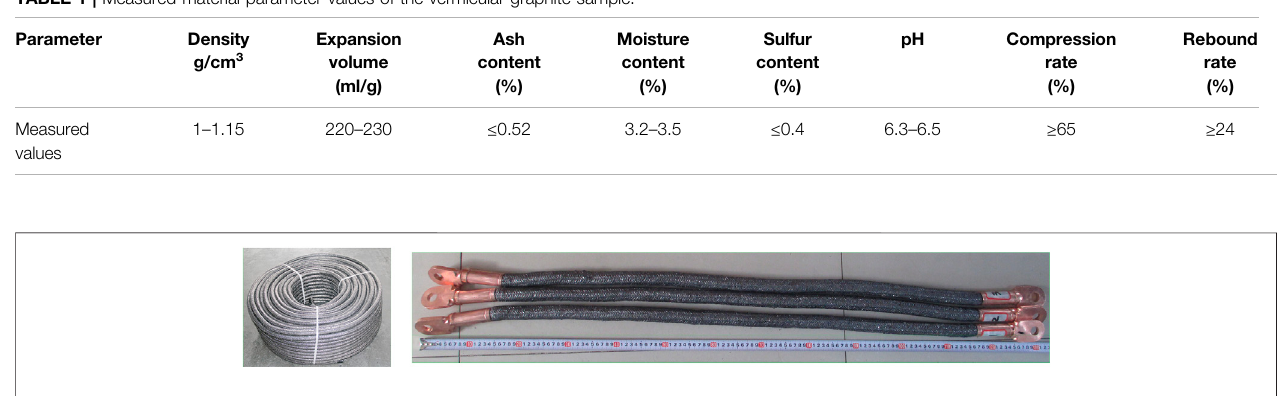
TABLE 1 | Measured material parameter values of the vermicular graphite sample.